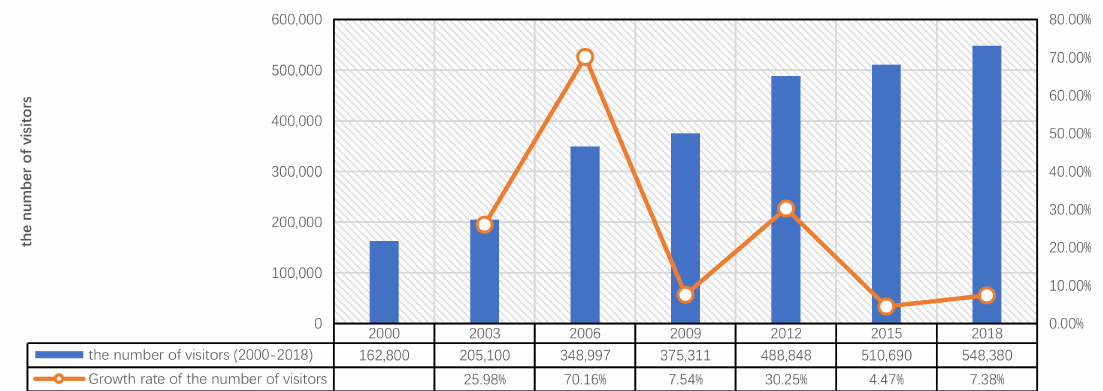
Figure 6. Changes in the number of visitors over the years